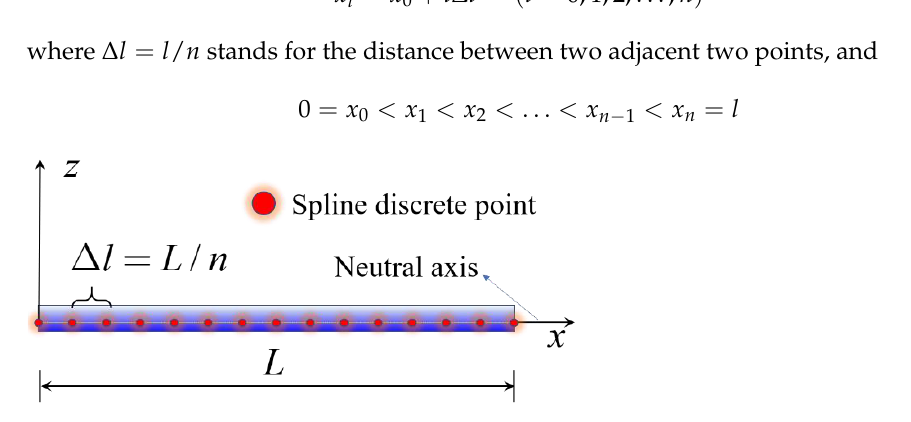
Figure 3. Diagram of finite point discretization for FGM nanobeam.